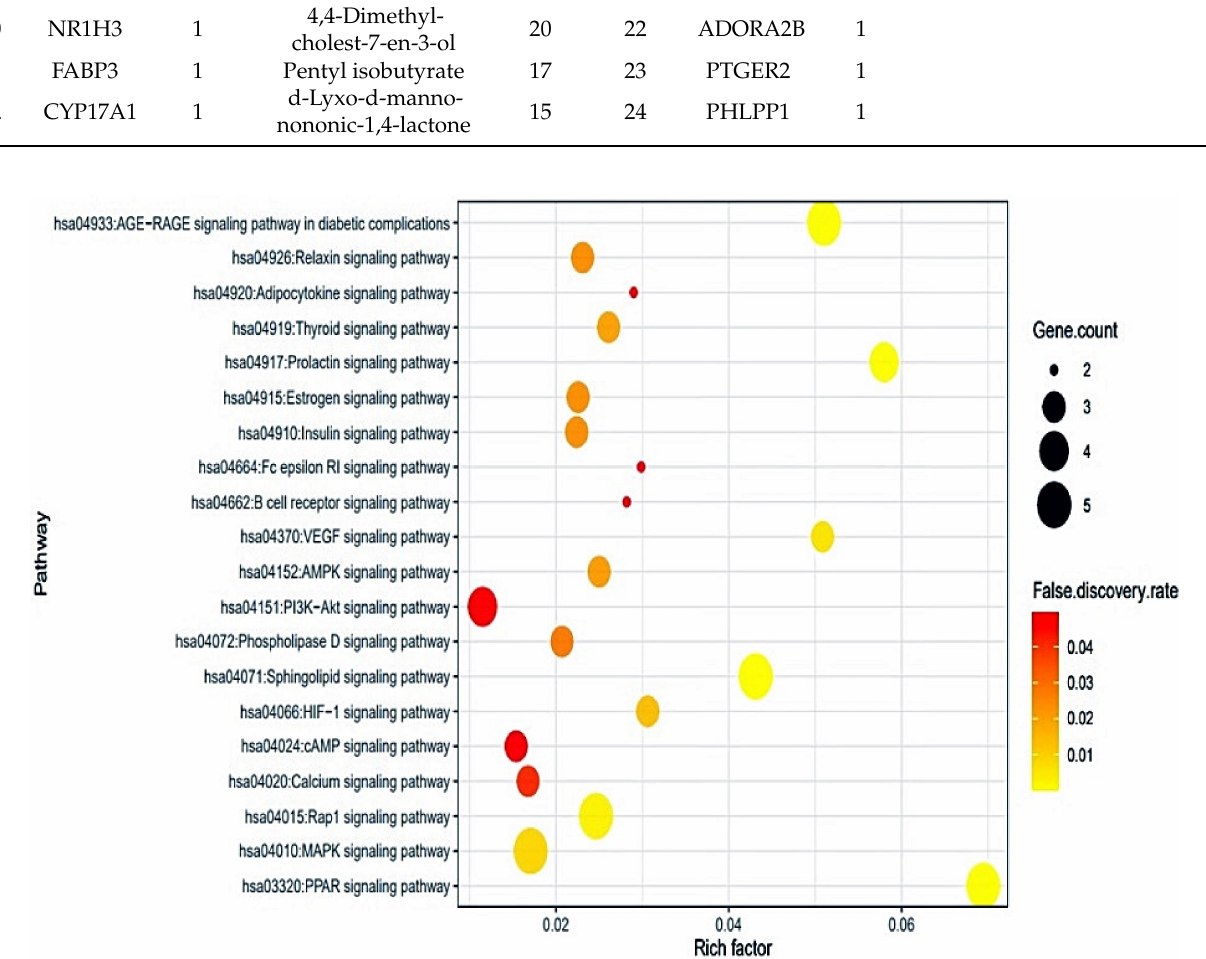
Figure 5. Bubble chart of 20 signaling pathways connected to